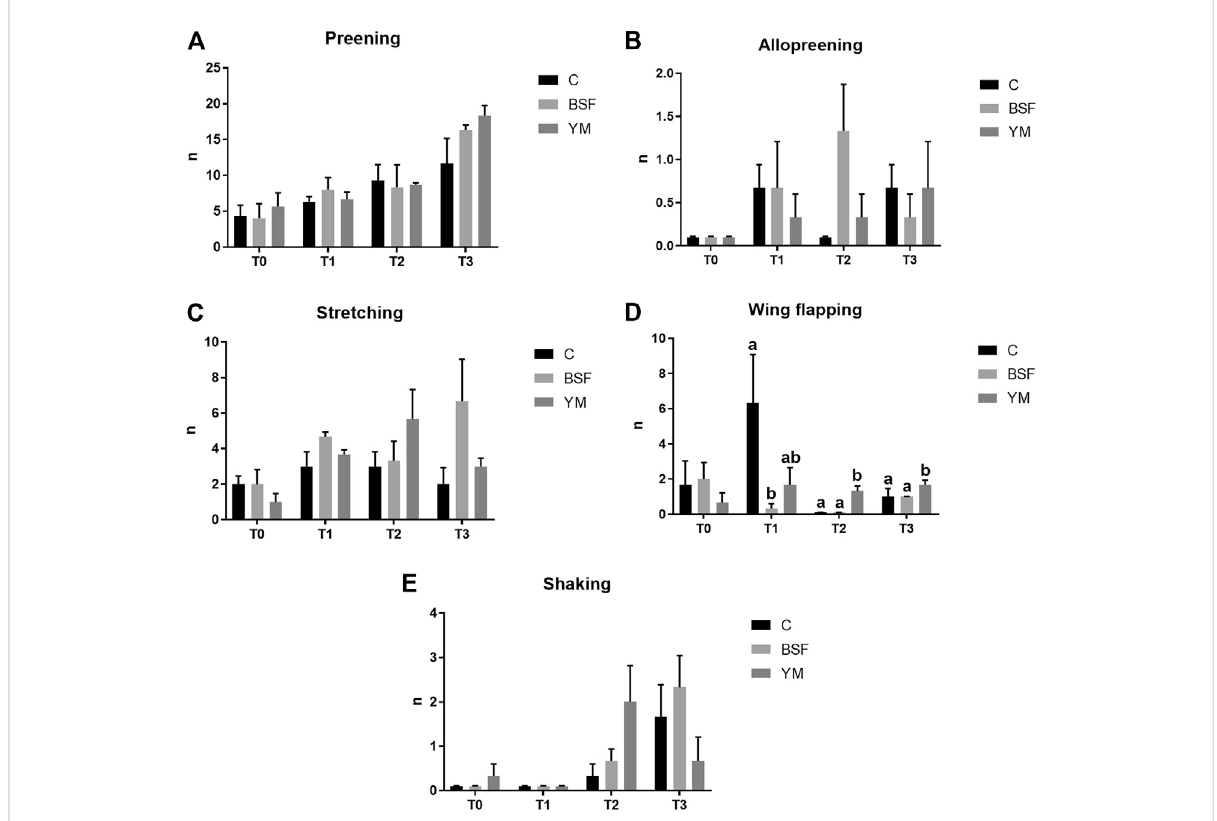
FIGURE 3 Frequency behaviours of the broiler chickens in the afternoon (diet*time interaction). (A) Preening. (B) Allopreening. (C) Stretching. (D) Wing fl apping. (E) Shaking. Graph bars (representing least square means) with different superscript letters (a, b) indicate signi fi cant differences among the experimentaltreatmentswithintheexperimentaltimes.C=controlgroup;BSF=Cdiet+blacksoldier fl ylivelarvae;YM=Cdiet+yellowmealworm live larvae. T0 = day 0; T1 = day 11; T2 = day 22; T3 = day